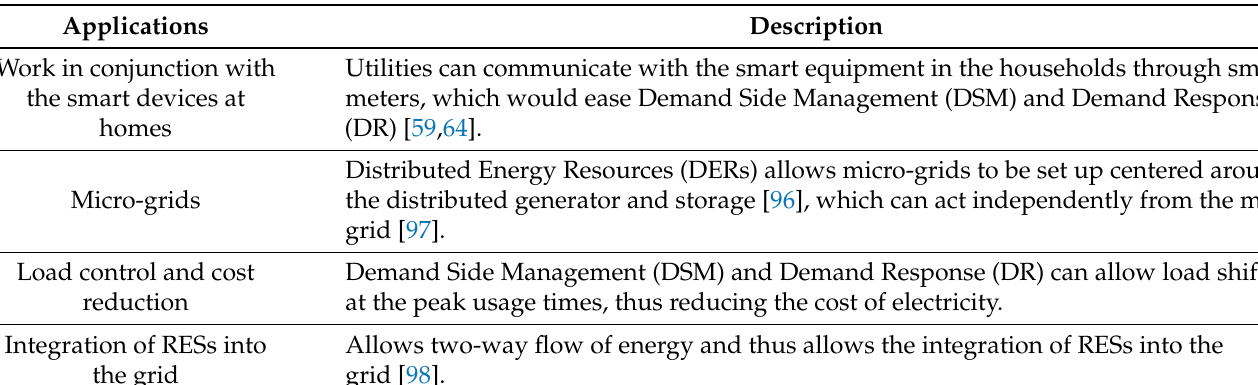
Table 7. Applications of the smart power management